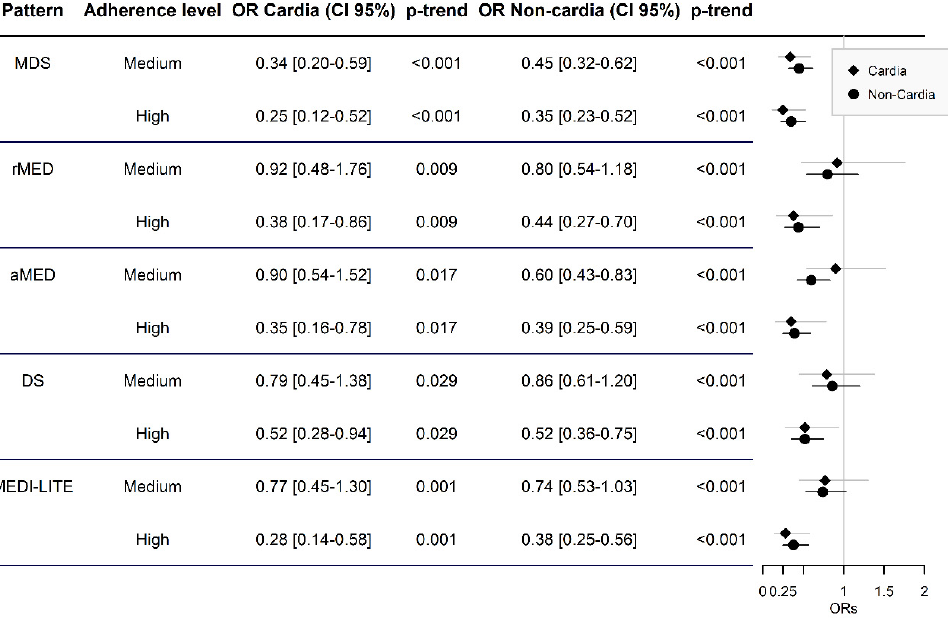
Figure 2. Odds ratios of risk of gastric cardia and non-cardia cancer according to adherence level to various indexes com- pared with low adhesion.